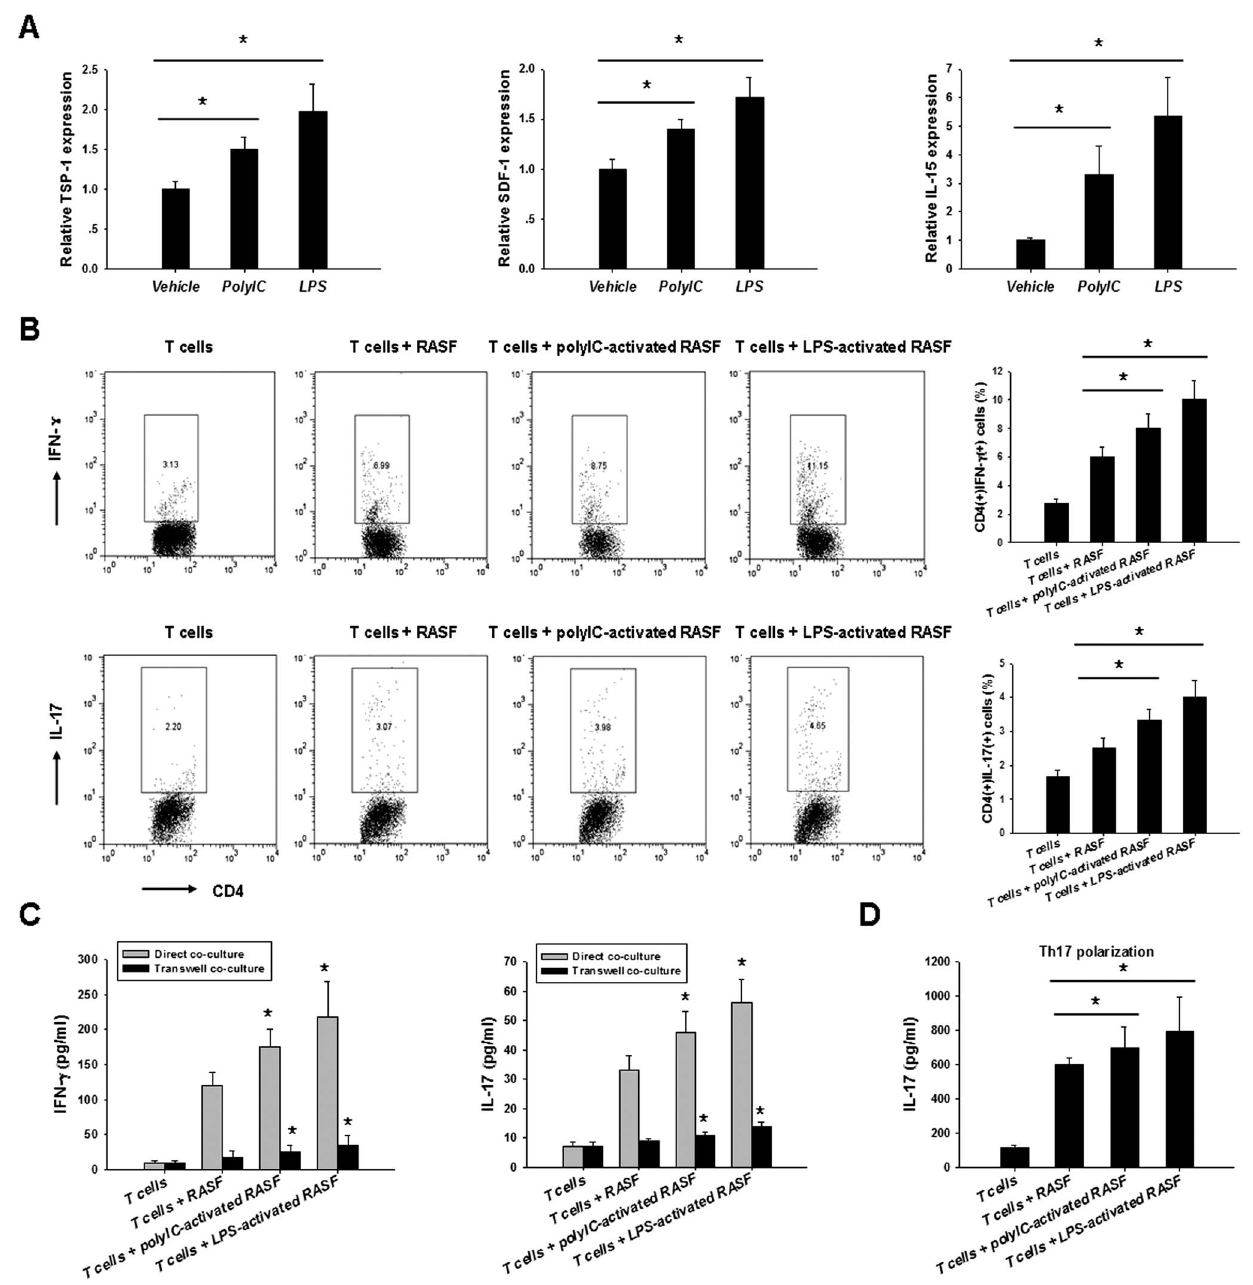
Figure 4. TLR activation enhanced RASF-mediated inflammatory Th1 and Th17 responses. A, RASF were stimulated with 25 m g/ml ploy(I:C) or 100 ng/ml LPS for 24 h, then the expression levels of TSP-1, SDF-1, and IL-15 were determined by realtime PCR analyses (Wilcoxon signed- rank test, * P , 0.05). B, After activation with 25 m g/ml ploy(I:C) or 100 ng/ml LPS for 24 h, RASF were co-cultured with allogeneic CD4 + RA patient T cells in the direct contact or the transwell systems for 5 days. Then the T cells were harvested for flow cytometry analysis of the percentage of Th1 and Th17 cells (Wilcoxon signed-rank test, * P , 0.05). Accordingly, the cell culture supernatants were collected for ELISA analyses of IFN- c and IL-17 (C) levels (Wilcoxon signed-rank test, * P , 0.05 vs. unstimulated control). D, RASF/T cell co-culture was performed as described above under Th17 polarization conditions. 5 days later, the cell culture supernatants were collected for IL-17 ELISA (Wilcoxon signed-rank test, * P , 0.05). The data were shown as mean + SEM of four separate